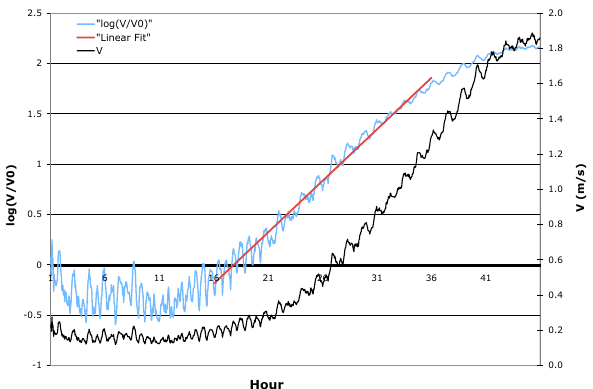
Fig. 3. Time series of the surface maximum meridional wind (black; y -axis on the right) and its natural logarithm (blue; y -axis on the left) from the dry WRF simulation. The red straight line is a linear fit on a log-linear scale from Day 16 to Day 35, implying an e-folding time of approximately 9.8days.